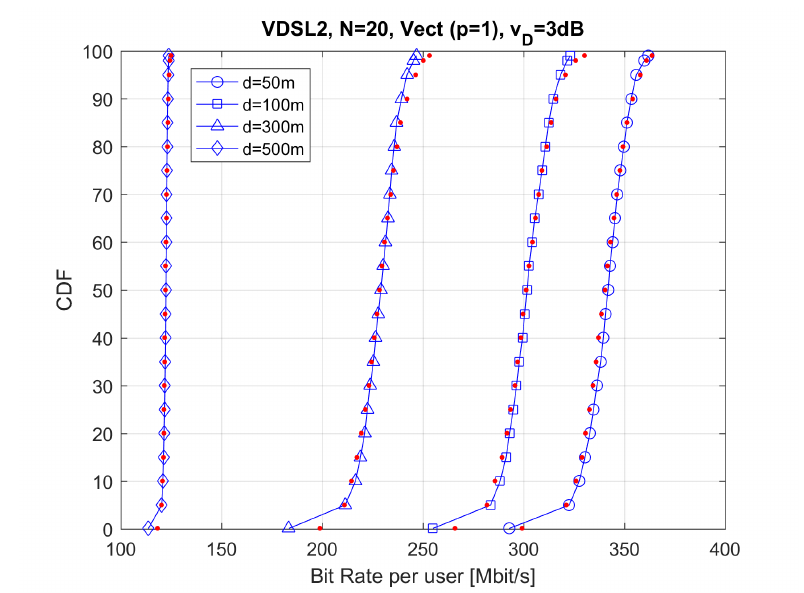
Figure 2. Cumulative distribution functions (CDFs) for the bit rate per user in the vectoring case with p = 1 for N = 20; exact (solid) and Gaussian approximation (dots).